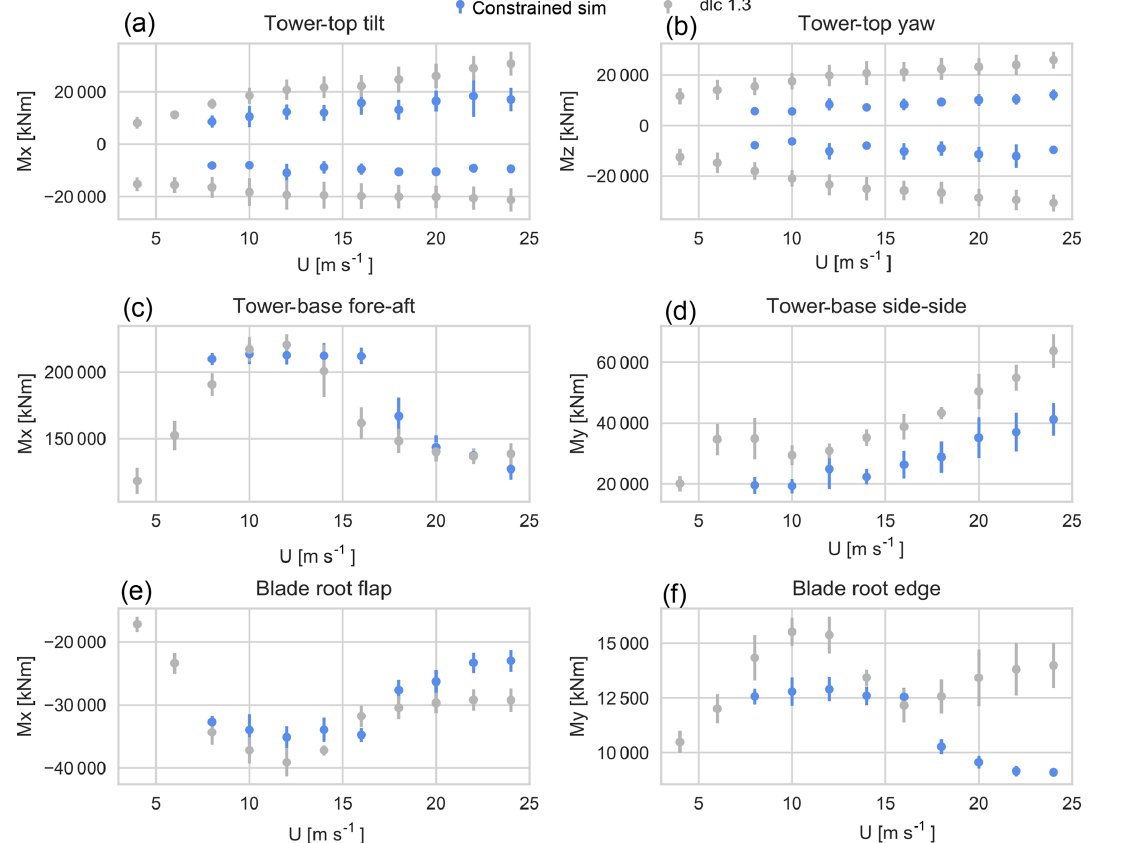
Figure 9. The mean extreme moments from IEC DLC 1.3 (grey dots) and the mean extreme loads from the constrained simulations (blue dots). Table 3. The highest mean extreme moments for different load